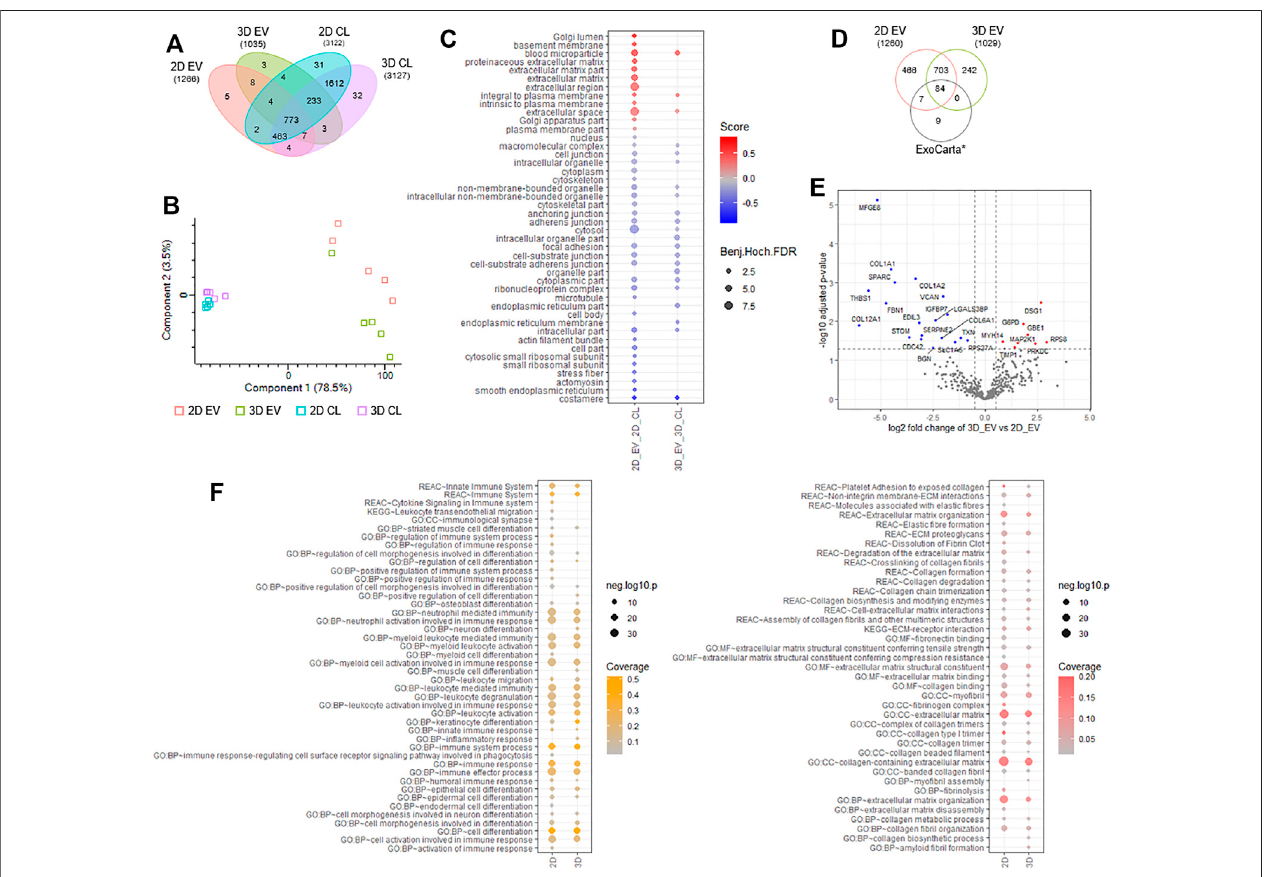
FIGURE9| Proteomicanalysesof2Dand3DMSC-derivedextracellularvesicles(EVs). (A) Venndiagramdisplayingnumberofproteinsidenti fi edinEVsanddonor cellsgrownin2Dand3Dconditionusinglabelfree-basedmassspectrometryfromeachgroup. (B) principalcomponentanalysisofEVsanddonorcellsgrownin2Dand 3Dcondition. (C) BalloonplotdisplayingGeneOntologycellularcomponentenrichmenttermsofEVvscellsineachcondition(Benjamin-HochbergFDR < 0.05). (D) Venn diagram displaying number of proteins identi fi ed in EVs from each group compared to exosome/EV database, ExoCarta (top 100 abundant proteins). (E) Volcano plot displayingdifferential protein expression ofEVs derived from 2D and 3D growth condition. (F) Balloon plot displayingg:Pro fi lerenrichmentterms (Reactome, KEGG pathways, Gene Ontology: biological process, molecular function, cellular component) in EVs from each group ( p < 0.05). Left panel: “ immune-based associated function, ” right panel: “ fi brosis-related function ”